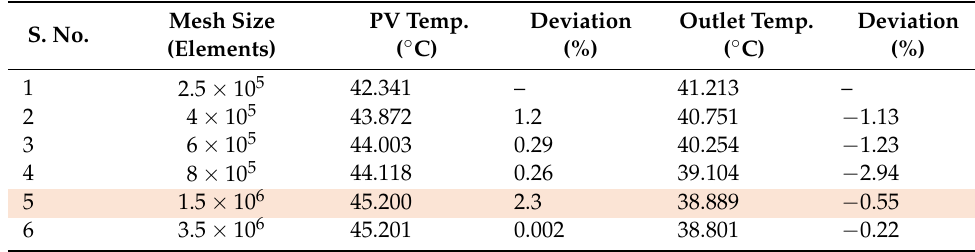
Figure 4. ( a ) 3D grid generation of the computational domain, ( b ) Poly-hexacore meshing of the PVT system, ( c ) Inflation layer at the solid-fluid interface. Table 4. Grid independency test.